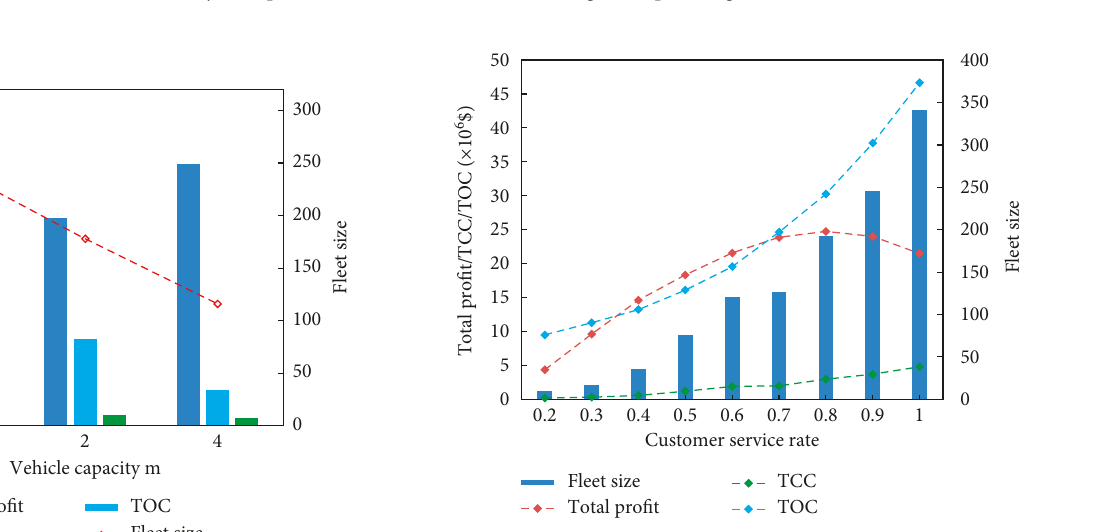
Figure 12: The effect of customer service rate on the system